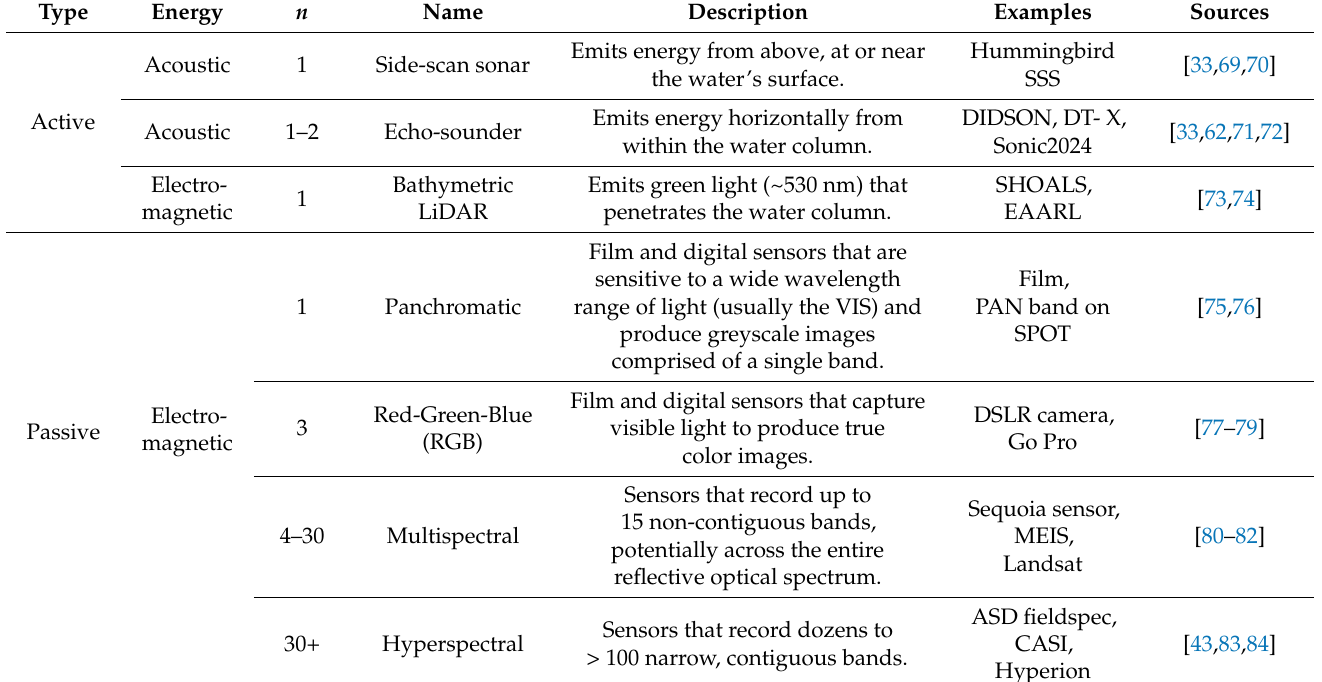
Table 2. The types of remote sensors that have been commonly applied to the study and monitoring of SAV, categorized by type, energy measured and number of bands ( n ). Example sensors and sources detailing applications of these sensors are also